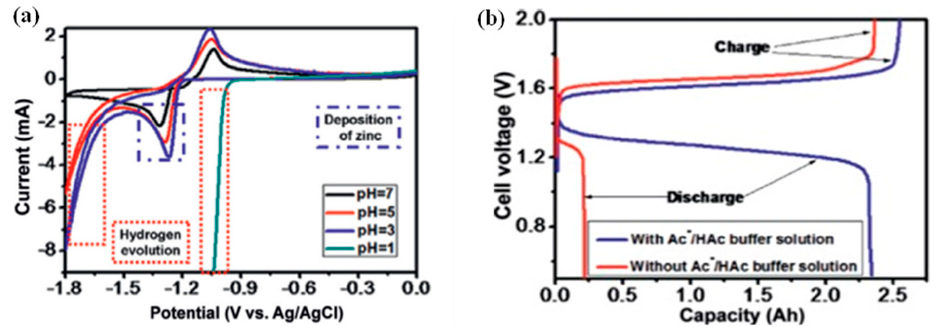
Figure 14. ( a ) CV curves of Zn/Zn 2+ on graphite electrode; ( b ) the ZIRFB performance with and without HAc/NaAc buffer. Reproduced with permission from [53]. Copyright 2016, Elsevier.